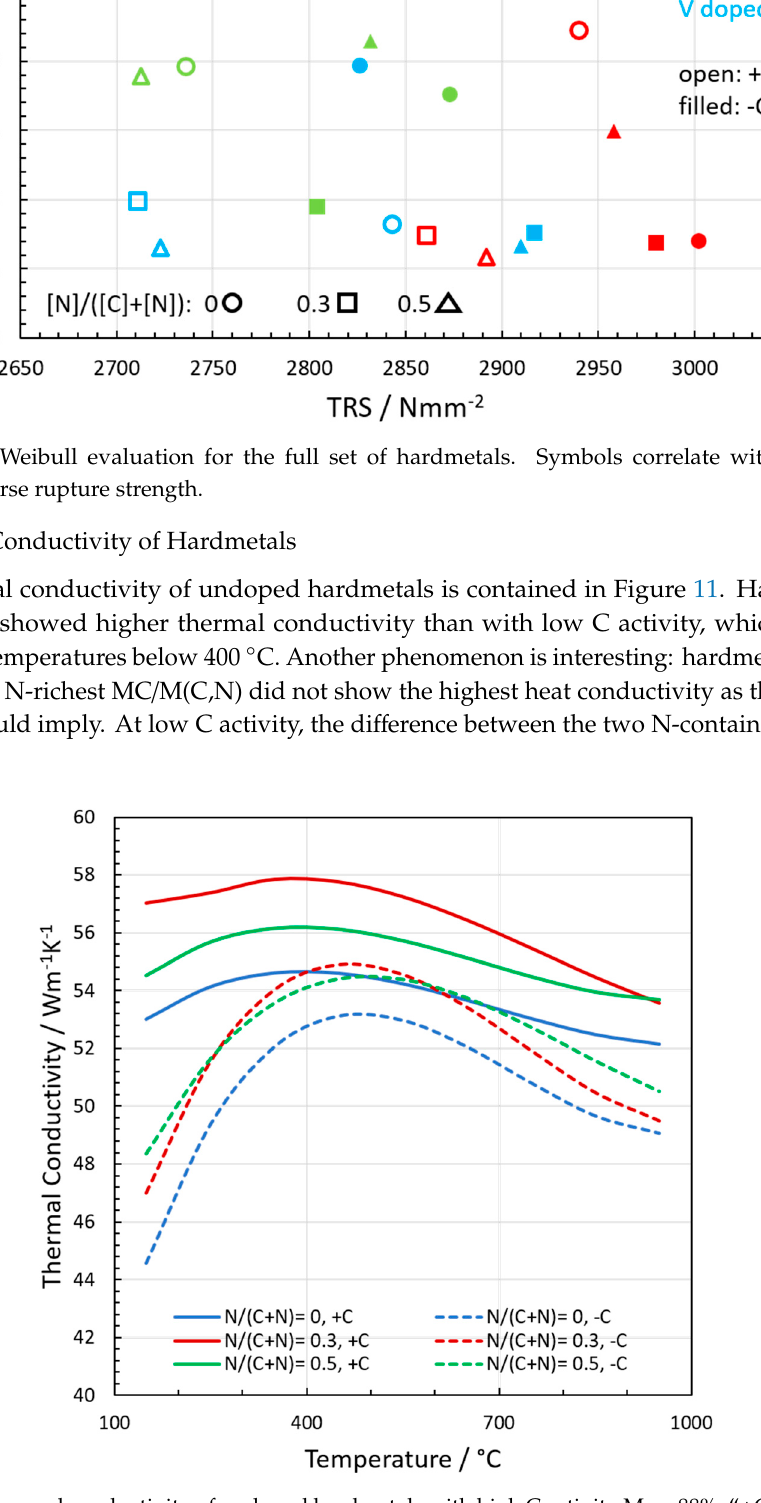
Figure 11. Thermal conductivity of undoped hardmetals with high C activity Ms ≈ 88%, “ + C”, full lines and low C activity Ms ≈ 75%, “ − C”, broken lines and different nitrogen content in the TiC/TiN phase added, [N]/([C]+[N]) = 0, 0.3 and 0.5.